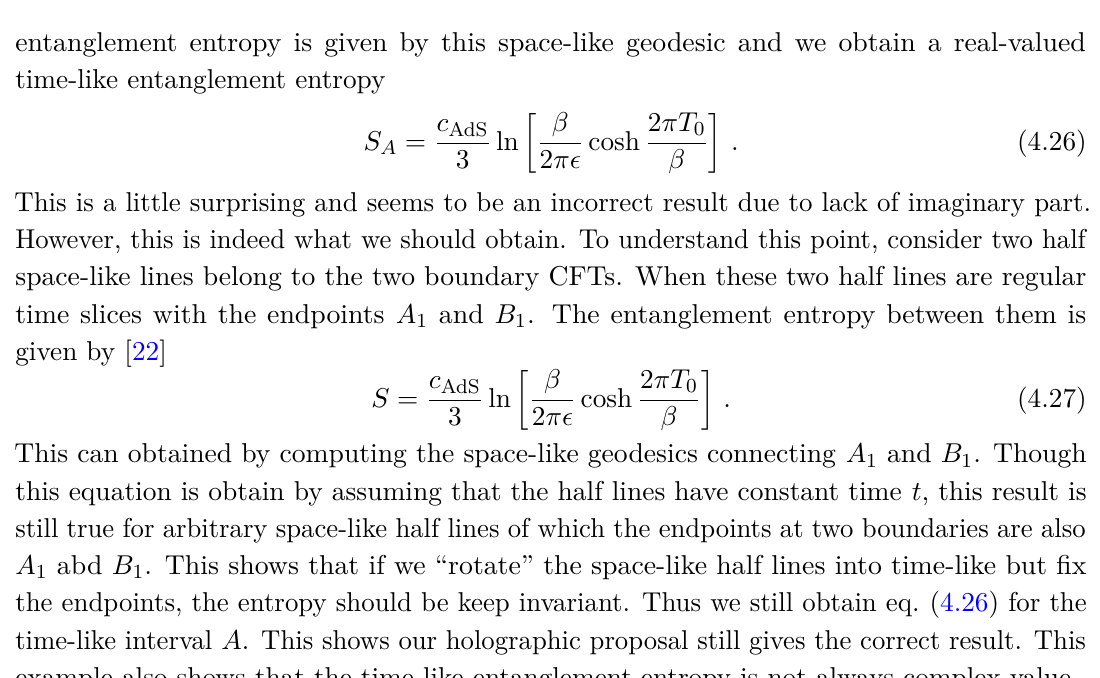
Figure 10 . The two space-like half lines are denoted by blue dots and the two time-like half lines are denoted by golden solid lines. The arrows indicate the time direction of two